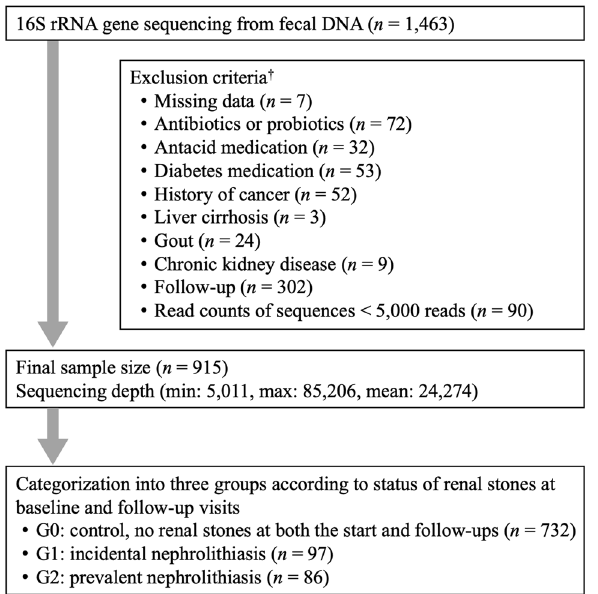
Figure 1. Inclusion and exclusion criteria for study participants. † Some individuals met several exclusion